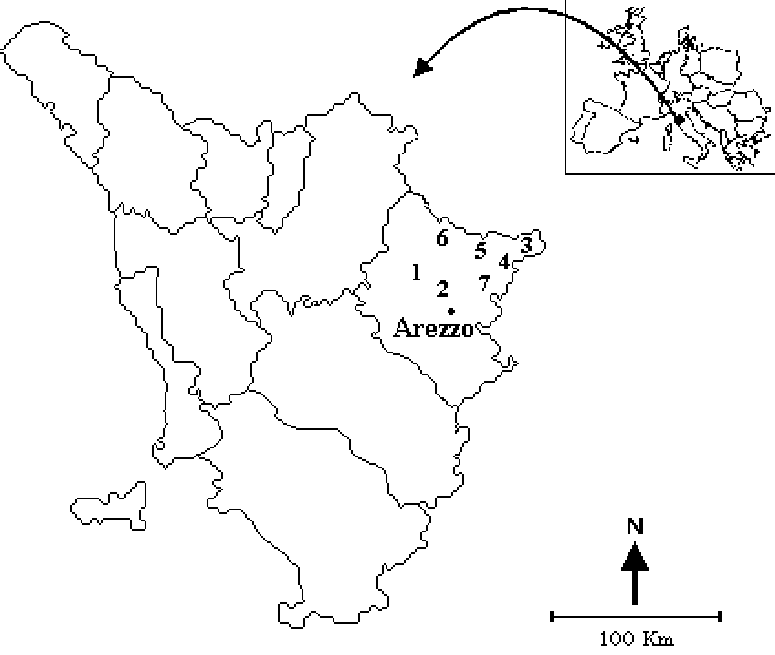
Fig. 1. Map of the study areas. 1 – Valle dell’Inferno e Bandella; 2 – Ponte a Buriano e Penna; 3 – Sasso di Simone; 4 – Alpe della Luna; 5 – Montalto; 6 – Alta Valle del Tevere; 7 – Monti